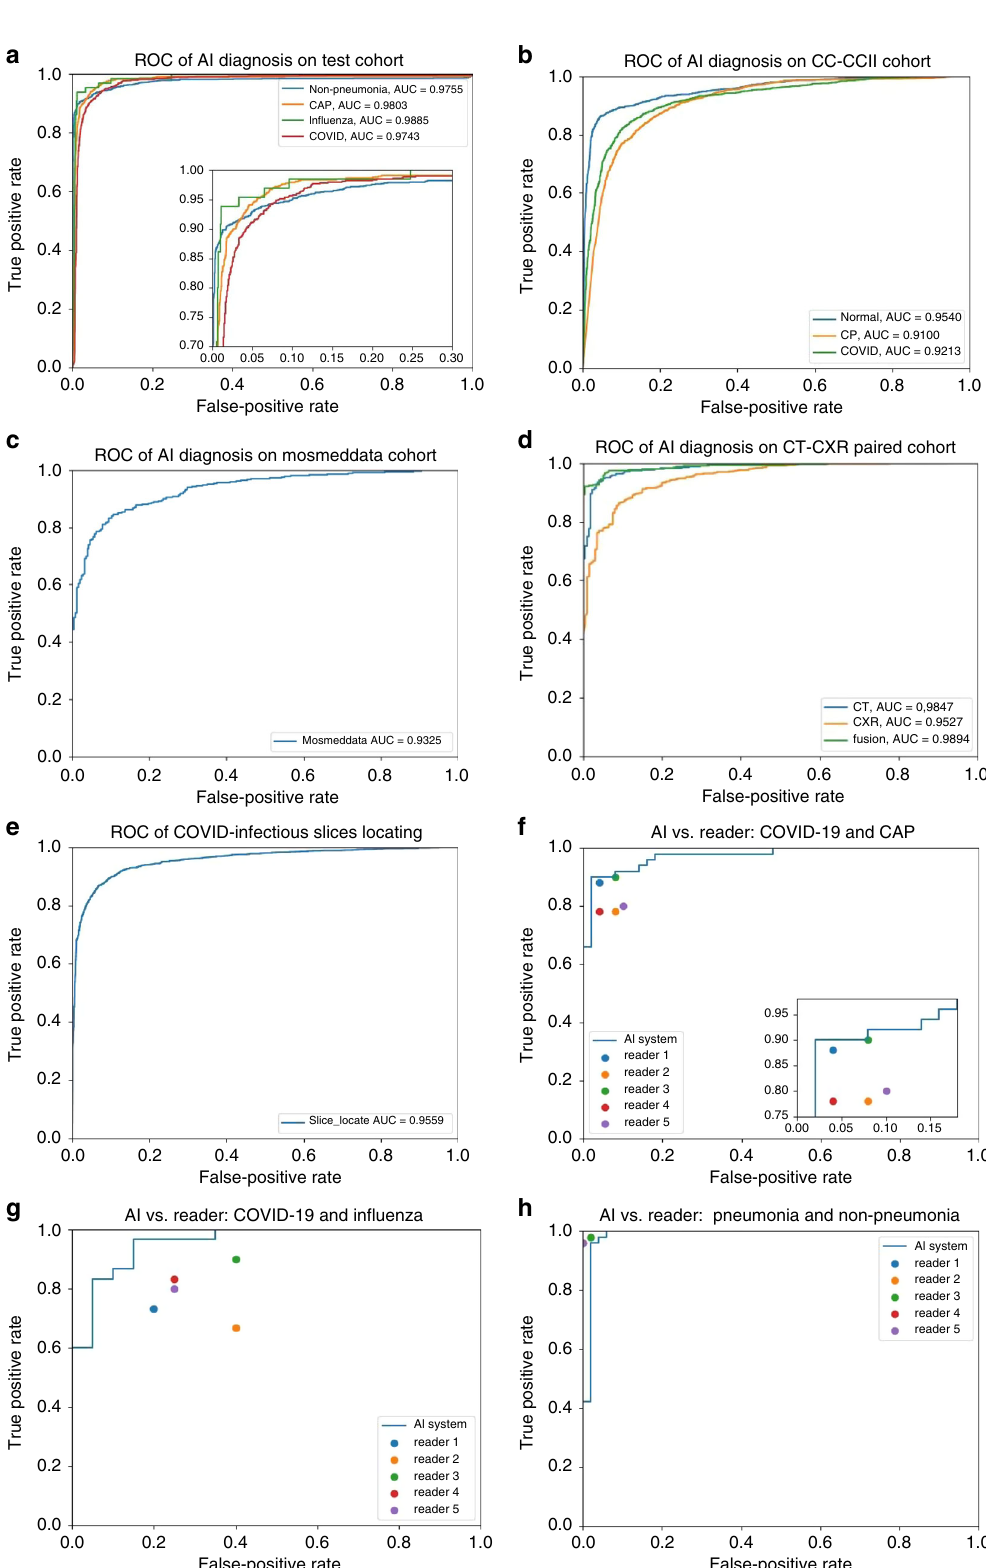
Fig. 2 Receiver operating curves of the AI system. a ROC curves of AI system on test cohort. b ROC curves of AI system on CC-CCII test cohort. c ROC curve of AI system on MosMedData test cohort. d ROC curves of CT-based AI system and CXR-based AI system on sub-cohort of test cohort, which has paired CT and CXR data. e ROC curve of AI system on COVID-infectious locating. f ROC curve together with reader performances on CAP-or-COVID cohort. g ROC curve together with reader performances on in fl uenza-or-COVID cohort. h ROC curve together with reader performances on pneumonia-or- non-pneumonia